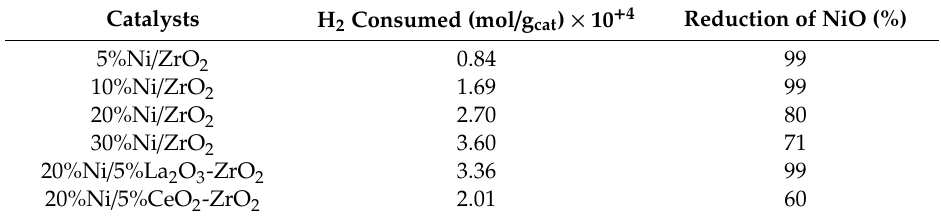
Table 3. Amount of hydrogen consumed during the TPR run and the estimated reduction degree for the nickel